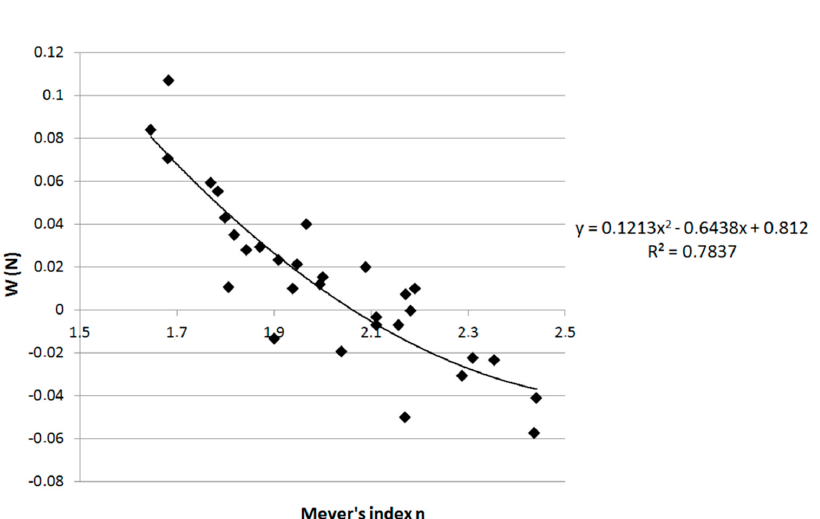
Figure 3. The relationship between Meyer’s index n and W, the minimum test load W (N) necessary to initiate plastic deformation.